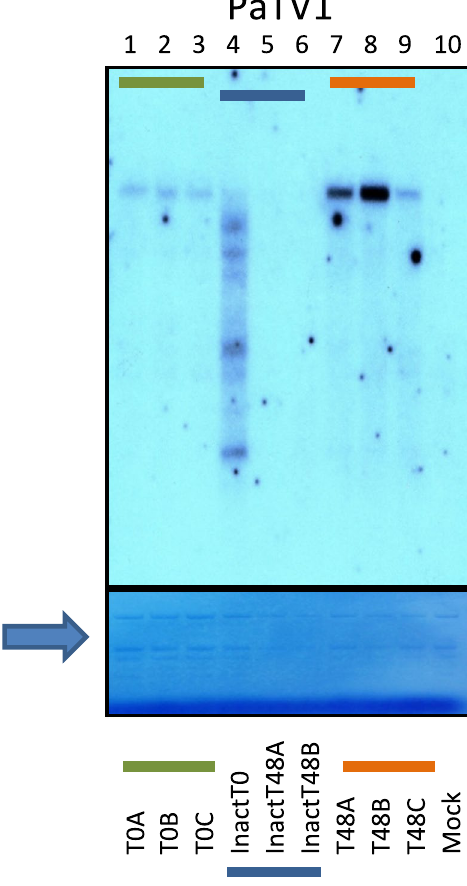
Figure 5. Northern blot analysis of total RNAs extracted from WT Nicotiana benthamiana protoplasts. A riboprobe was used to detect Penicillium aurantiogriseum totivirus 1 (PaTV1). The first three columns (green line, biological replicates T0 A , T0 B and T0 C ) show lanes loaded with total RNA from T0 transfected protoplasts. Columns 7 to 9 (orange line, biological replicates T48 A , T48 B and T48 C ) show lanes loaded with total RNA extractions of three more replicates transfected with untreated virus inocula harvested 48 hours after transfection. Columns 4 to 6 (blue line, biological replicates inactT0, inactT48A, inactT48B) show lanes loaded with total RNA for protoplasts transfected with inactivated viral purification: column 4, total RNA from viral inactivated transfected protoplasts at T0 showing clear signs of degradation of viral RNA (lack of a full length genomic RNA, and a number of lower molecular weight bands). In columns 5 and 6, total RNA from viral inactivated transfected protoplasts at T48, the viral genomic RNA and derivatives are completely cleared. As visible in methylene blue staining rRNA (arrow) amount was lower at T48 than at T0 in all samples, but the viral amount is higher only in untreated T48 protoplasts. Column 10 show mock inoculated protoplasts as negative control. The northern blot represent the full membrane; the lower panel represent the same membrane stained with methylene blue and cropped in the lower and upper part to show only the stained ribosomal